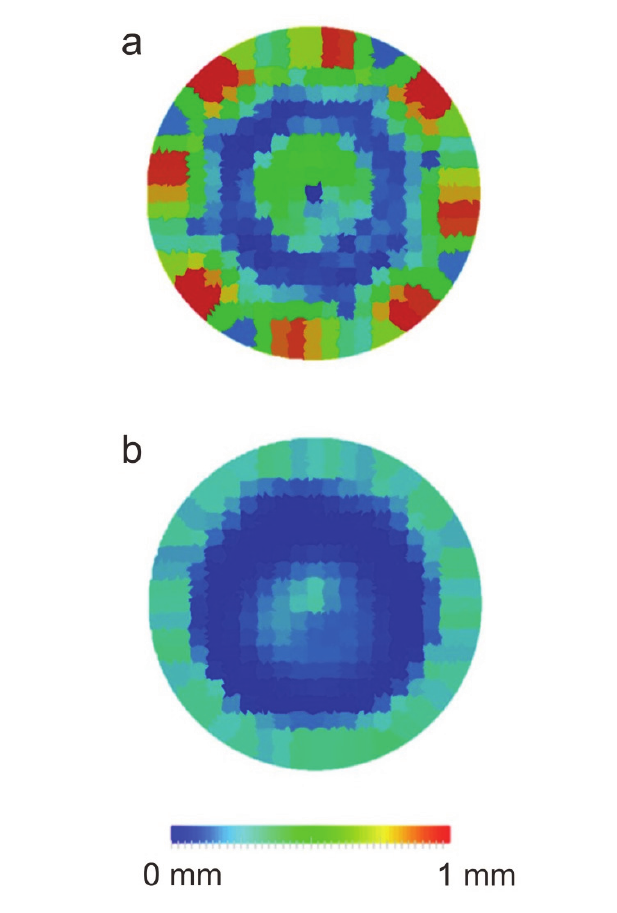
Fig. 3: Computer simulations of the positional accuracy of the customised method using (a) 8+1 and (b) 32+1 electrodes. The positional accuracy (colour bar) for each perturbation location was computed as the distance (in mm) between the centre of the true and reconstructed object, displayed at the true perturbation